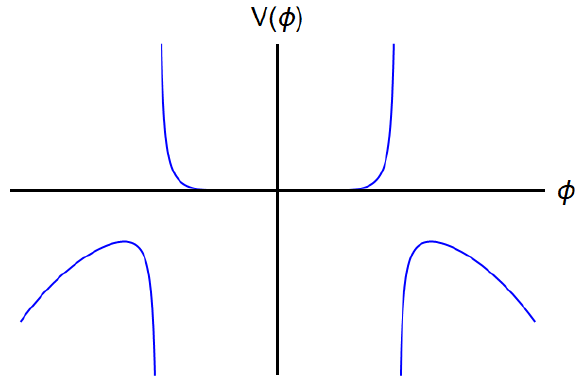
Figure 5 . Resummed φ 4 -potential.